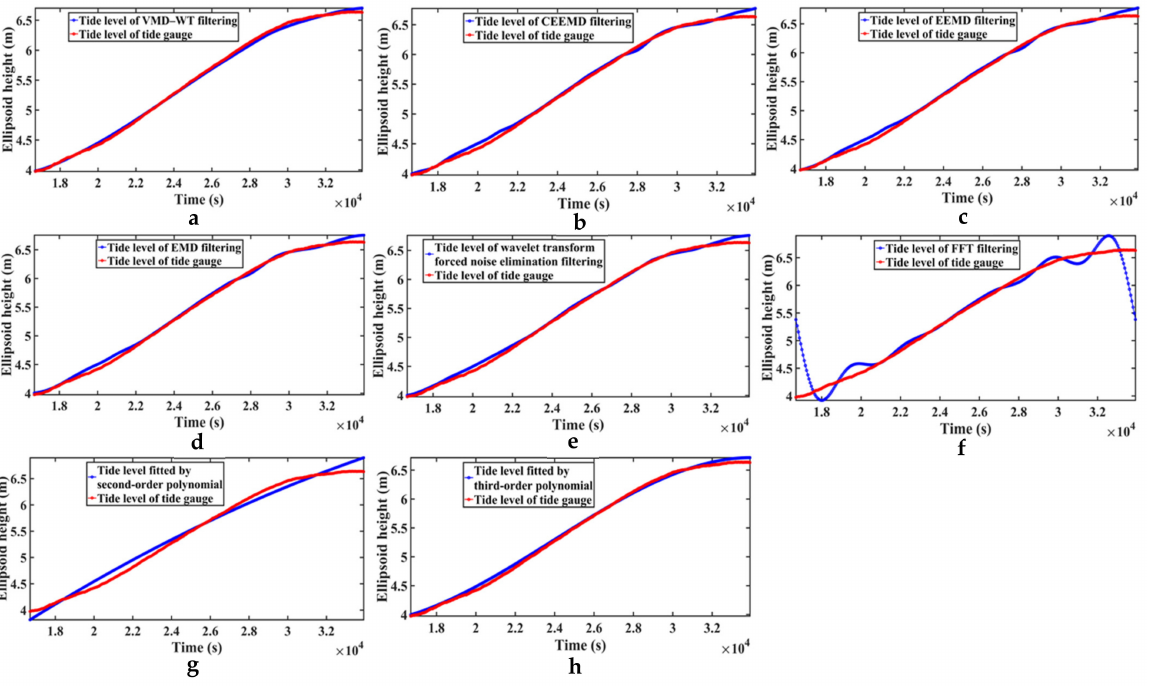
Figure 16. Comparison between the tide level of geodetic height extracted by eight filtering methods and the tide level of tide gauge for 4.8 h. ( a ) Tide level of VMD–WT filtering and the tide gauge; ( b ) Tide level of CEEMD filtering and the tide gauge; ( c ) Tide level of EEMD filtering and the tide gauge; ( d ) Tide level of EMD filtering and the tide gauge; ( e ) Tide level of wavelet transform forced noise elimination filtering and the tide gauge; ( f ) Tide level of FFT filtering and the tide gauge; ( g ) Tide level of second-order polynomial fit and the tide gauge; ( h ) Tide level of third-order polynomial fit and the tide